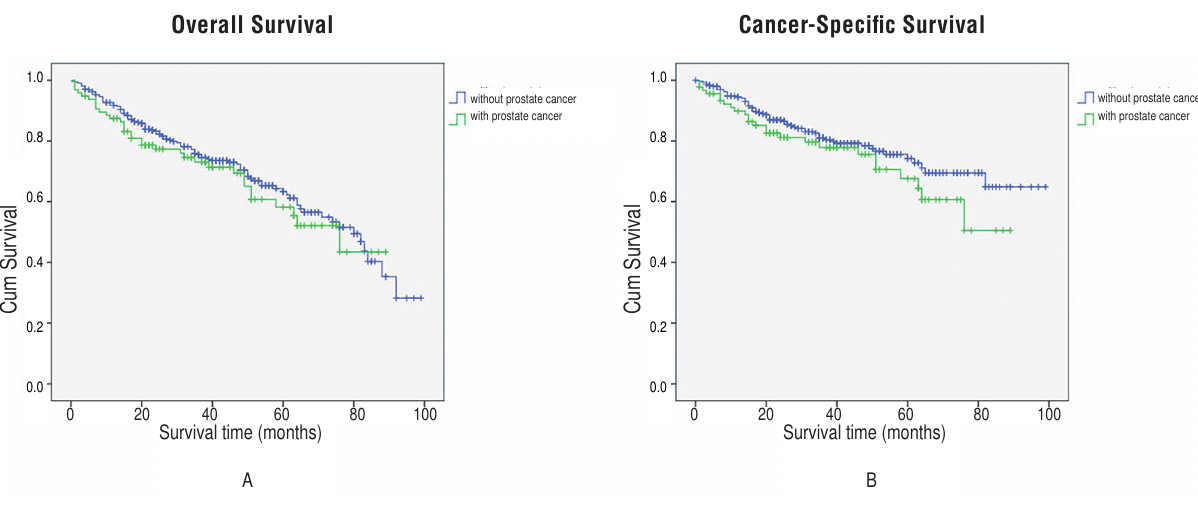
Figure 2 - Estimated Kaplan-Meier overall survival curves ( P =0.432) (a) and cancer-specific survival curves ( P =0.190) (b) stratified by presence of prostate cancer.